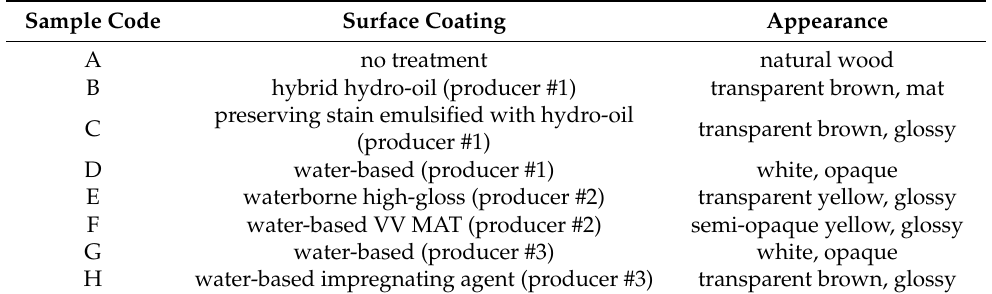
Table 1. Summary of acetylated Radiata pine samples tested within natural weathering